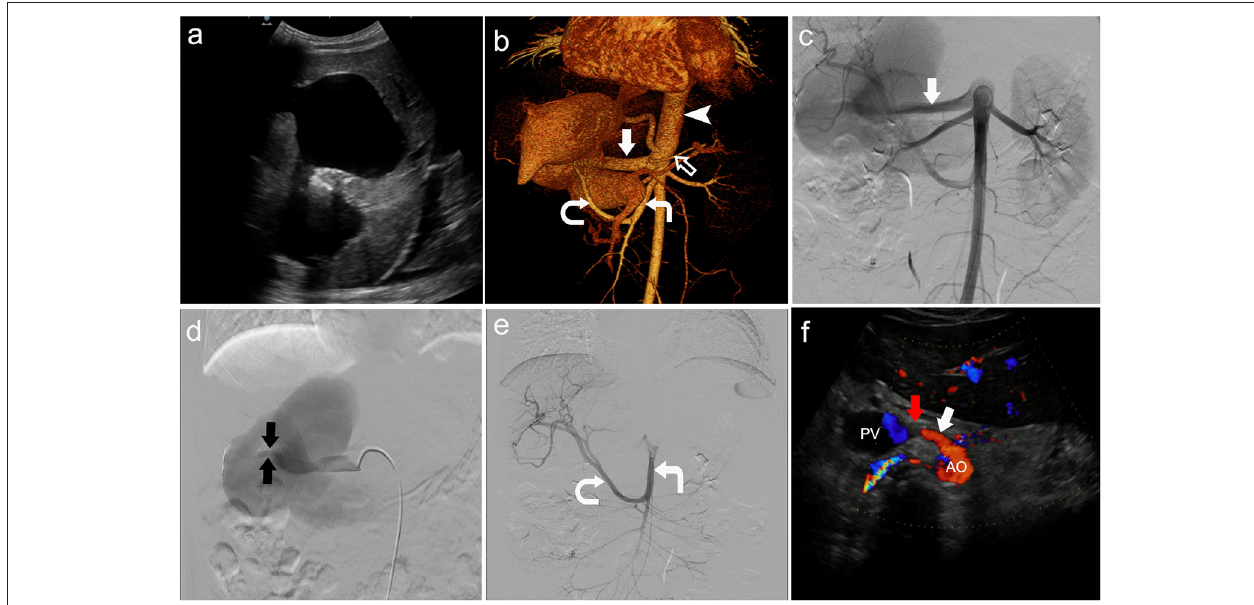
FIGURE 1 | Congenital visceral vascular variation was diagnosed by multi-imaging examinations. (a) Tumor-like expansion of the main portal vein and the left branch of the portal vein shown by color Doppler ultrasound. (b) Contrast-enhanced computed tomography scan showed the left hepatic artery (black arrow) and left gastric artery (not shown) co-trunk, as the first branch of the aorta (arrowhead). The common hepatic artery (straight solid arrow) and splenic artery (hollow arrow) originated from the front wall of the aorta below the left hepatic-gastric trunk, while the right hepatic artery (curved arrow) originated from the superior mesenteric artery (right angle arrow). (c) Angiogram showed the common hepatic artery (straight solid arrow). (d) Angiogram showed the fistula (the tiny blood vessels between the two black arrows). (e) Angiogram showed that the right hepatic artery (curved arrow) originated from the superior mesenteric artery (right angle arrow). (f) The position of the occluder (red arrow) was normal and the fistula was completely closed, 3 months after